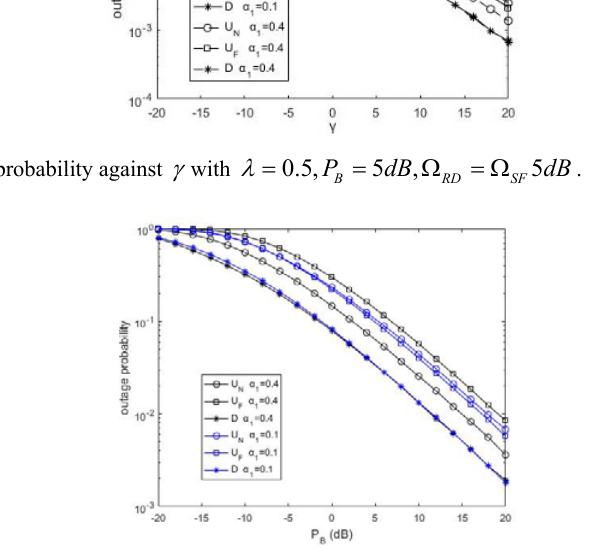
Fig. 2. Outage probability against γ with 0.5, 5